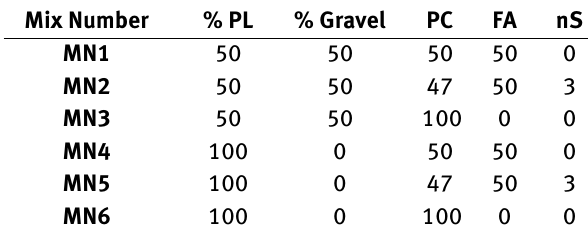
Table 3: Contents by volume percent of mixtures designs